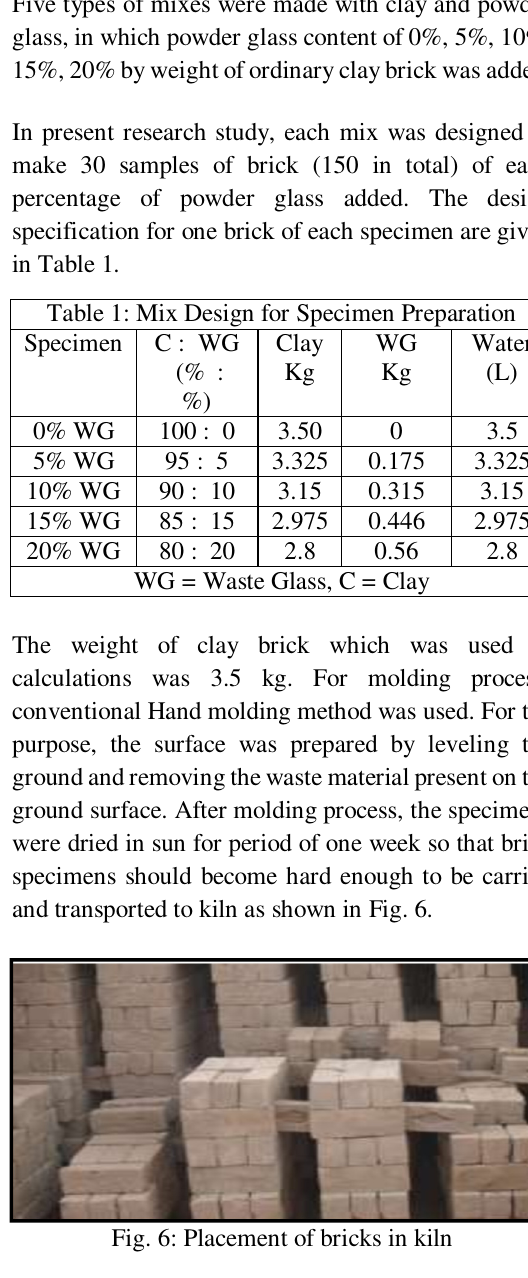
Fig. 3: Clay used for brick samples